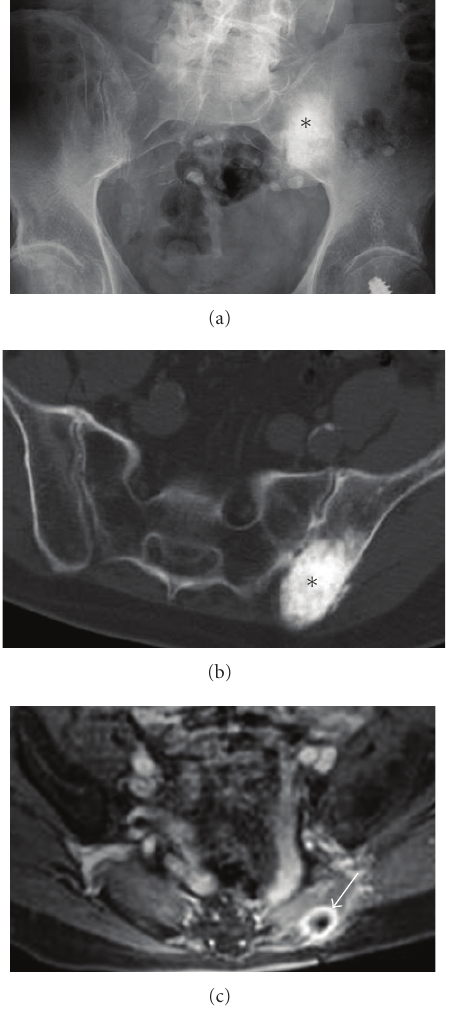
Figure 1: Conventional osteosarcoma. Elderly male presenting with a history of lower back pain diagnosed as conventional osteogenic sarcoma following biopsy. Anteroposterior (AP) radiograph (a) and axial CT scan (b) of the pelvis reveal aggressive bone-forming neoplasm involving the left ilium (asterisk). Follow-up axial T2 fat- saturated image (c) after tumor resection demonstrates an osseous metastasis with a characteristic peripheral halo (Arrow), which should not be confused with a metallic susceptibility